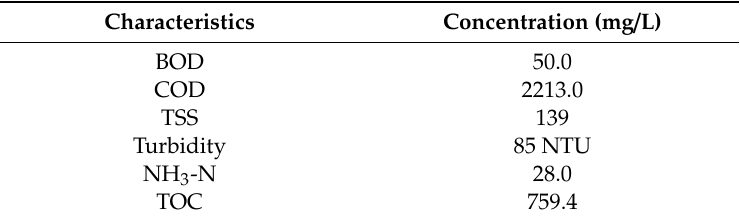
Table 3. Characteristics of produced